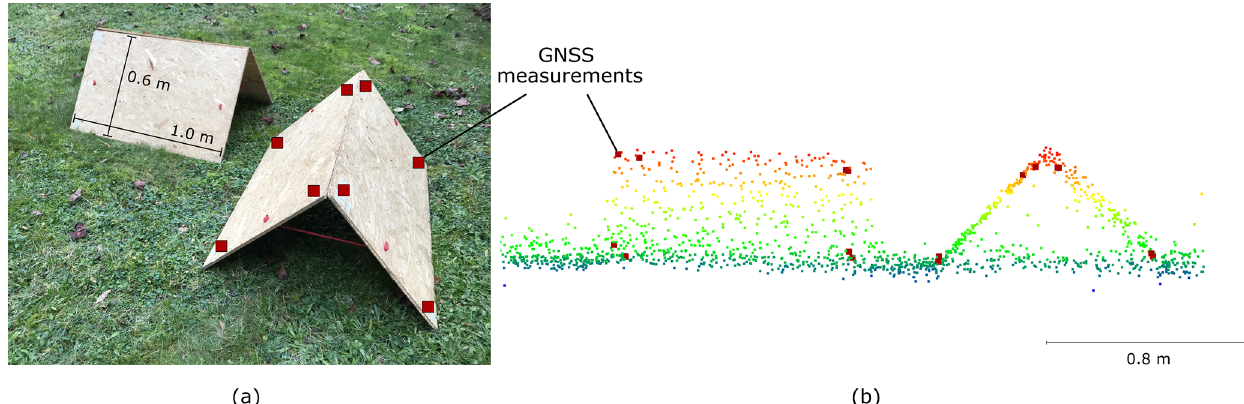
Figure 9. Roof-shaped wooden targets used for assessing the positional accuracy of the ULS point cloud. (a) Setup in the field. The two planes of each roof are 1m by 0.6m in size. The red squares in both images mark the points where GNSS measurements are taken. (b) View in a point cloud viewer. The ULS point cloud is colored by z coordinate, and the GNSS measurements are shown as large red squares. The georeferencing quality is considered good if the ULS points on the roofs agree closely with the GNSS reference measurements, as shown in this